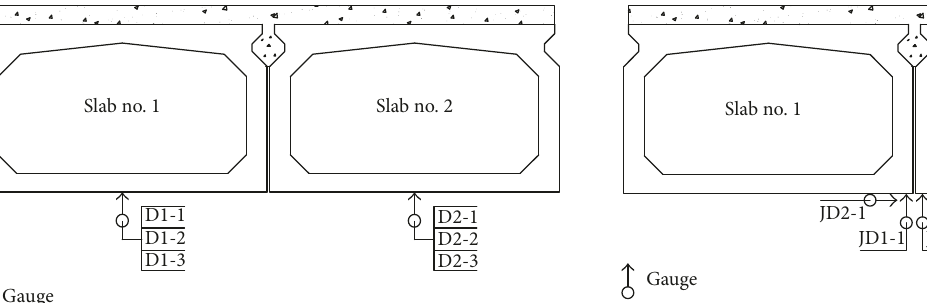
Figure 7: Deflection measurement points for the hollow slab.